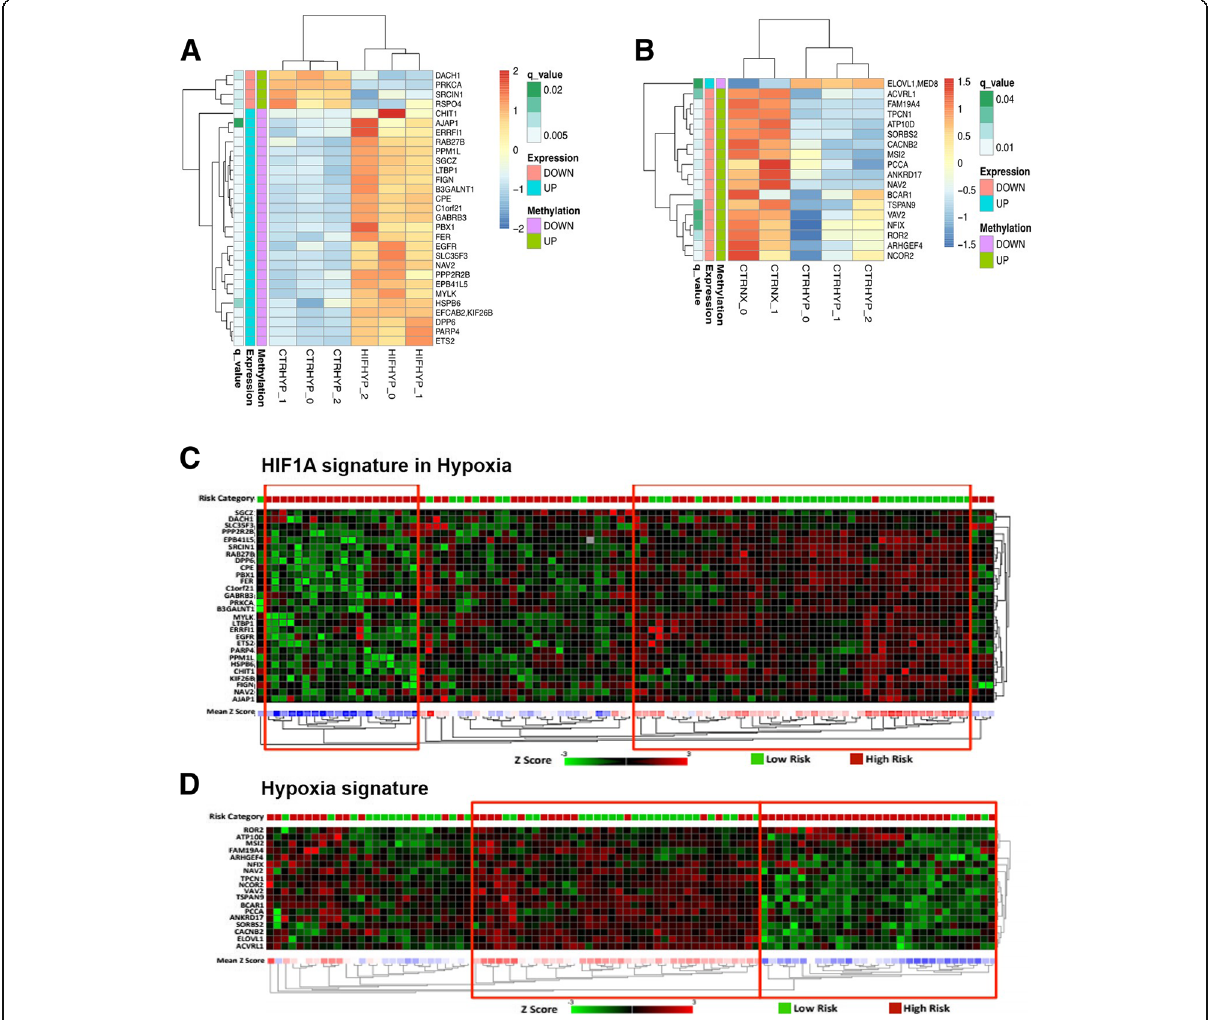
Fig. 4 Correlation of DNA methylation and gene expression in NB cells and in NB samples. Gene expression heat maps showing the correlation of gene expression with the methylation status (annotation tracks on the left) in shHIF1A HYP vs shCTR HYP ( a ) and in shCTR HYP vs shCTR NX ( b ) pairwise contrasts. “ q-value ” : FDR. a and b Obtained with the R package “ Pheatmap ” . Gene expression heat maps show genes included in c “ HIF1A signature in hypoxia ” and d “ Hypoxia signature ” . Low risk ( n = 40; in green) and High risk ( n = 56; in red) patients of the GSE73517 data set were used to draw the heat maps.. Red boxes indicate clusters of Low risk and High risk samples. c and d Obtained on the R2: Genomics Analysis and Visualization Platform (http://r2.amc.nl). a-d The expression values were first Z-Score transformed and then used to perform hierarchical clustering based on Euclidean distances. Z-Score ranges are reported in the color